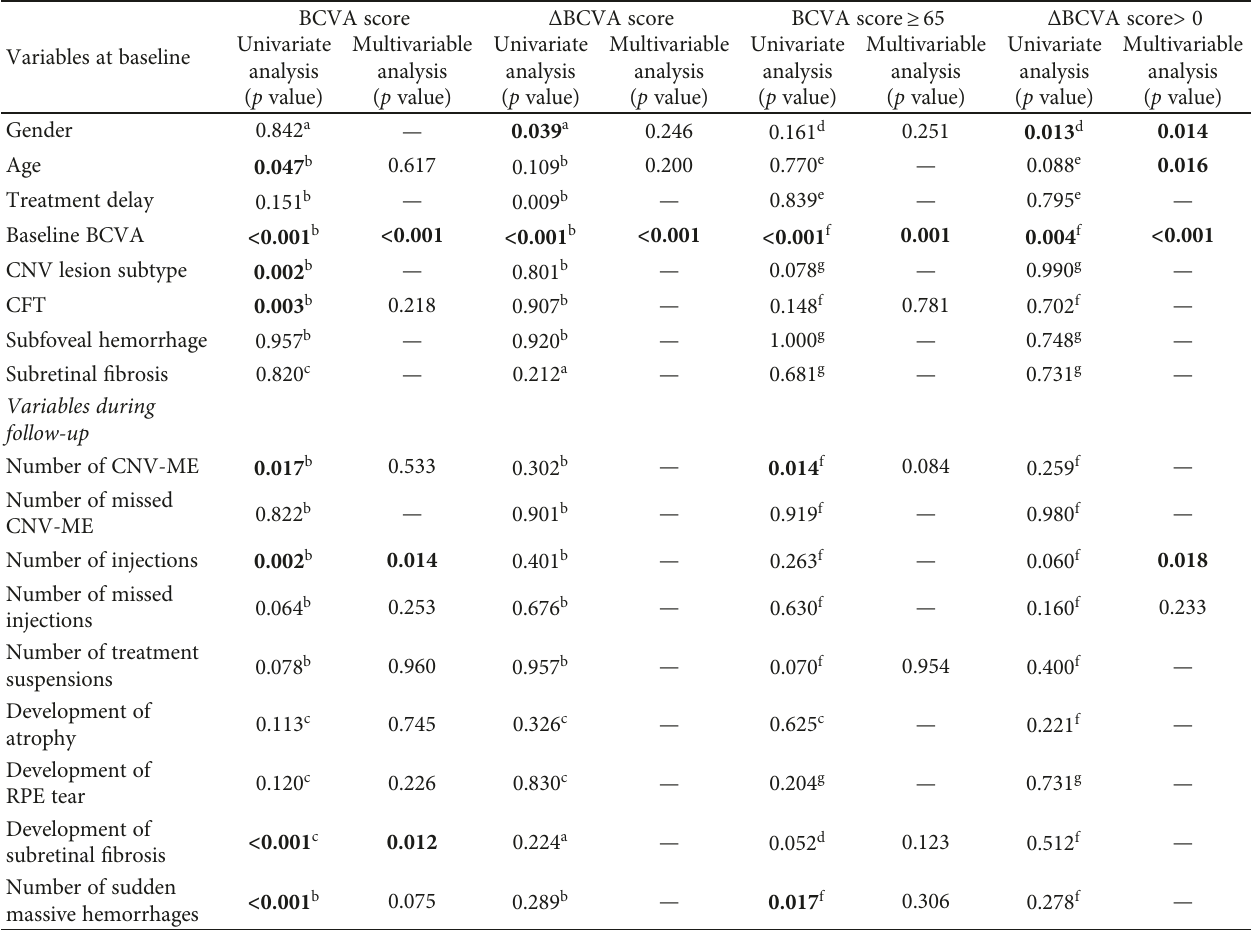
Table 4: Univariate and multivariate analysis for prediction of visual outcomes at 60